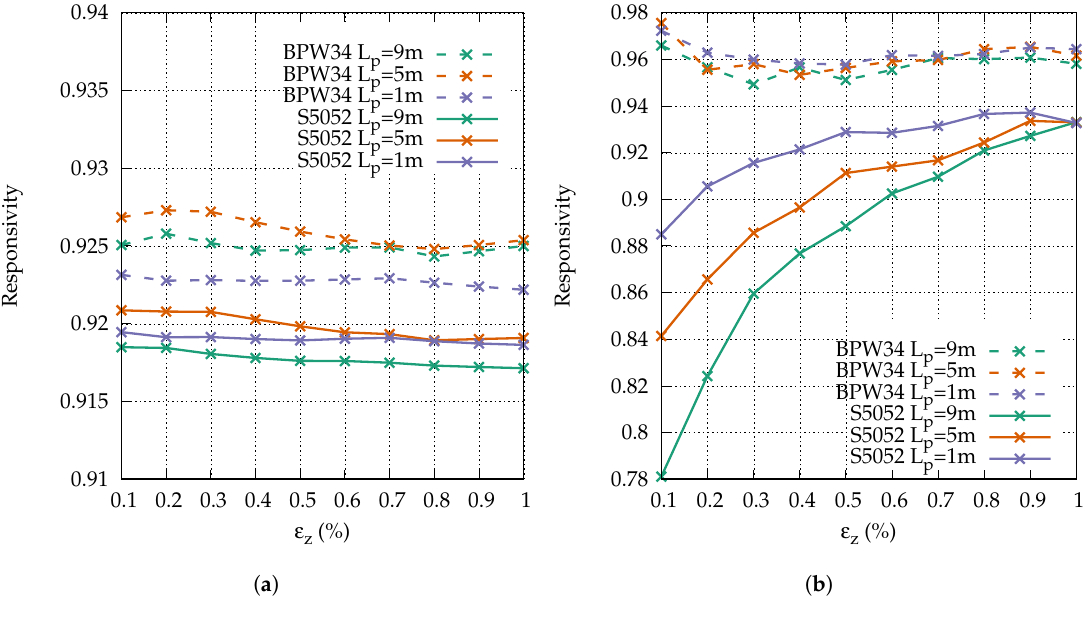
Figure 7. Simulated ( a ) and measured ( b )